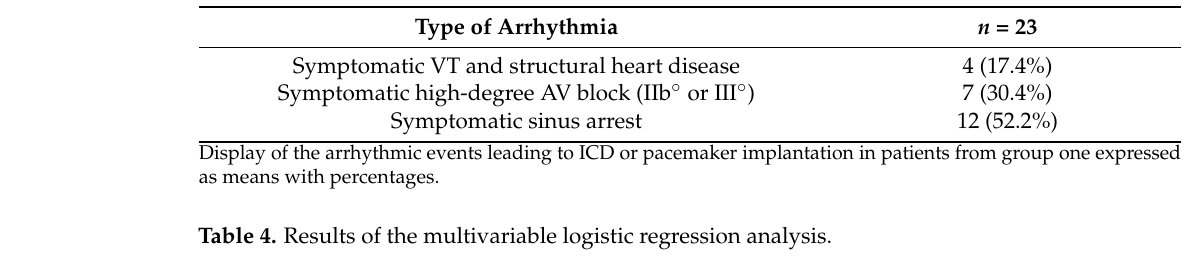
Table 3. Arrhythmic causes for recurrent syncopes detected by the ILR.